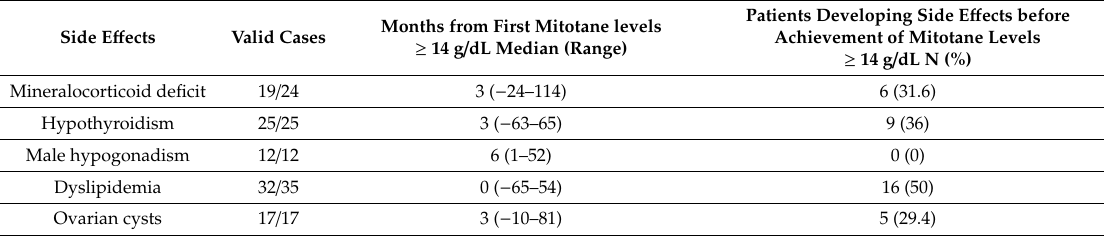
Table 4. Time relationship between the onset of side e ff ects and the achievement of target mitotane levels. Side E ff